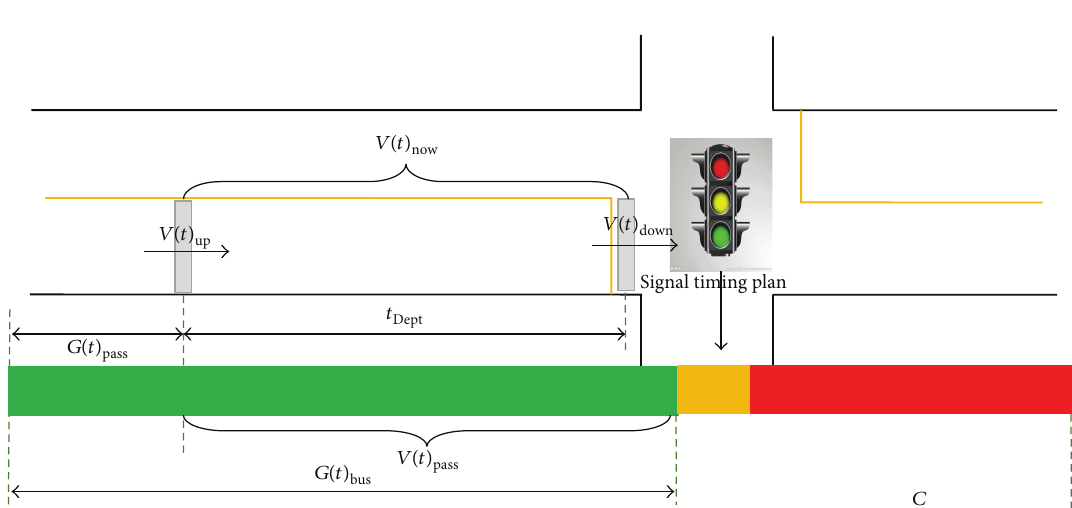
Figure 2: The components of arrival time estimation for transit vehicle.